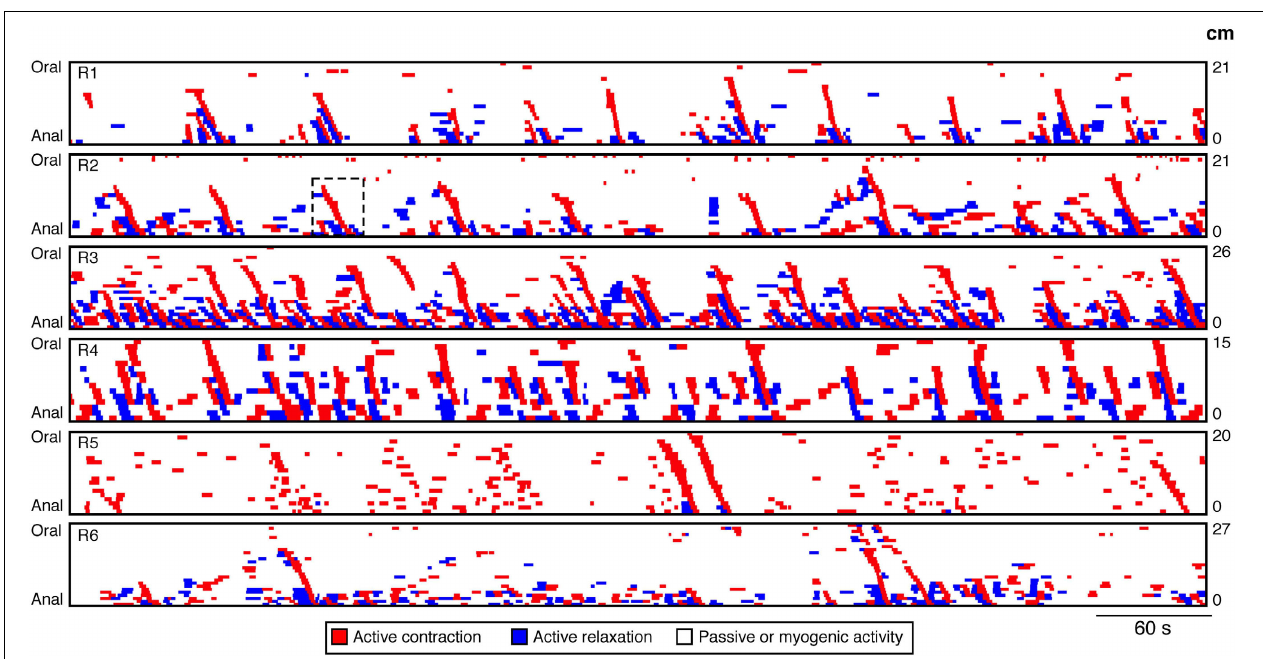
FIGURE 7 | DPMaps of neurogenic activity in the 6 rabbits. The active contractions are shown in red and the active relaxations are shown in blue. The white represents the passive states and myogenic active states. From